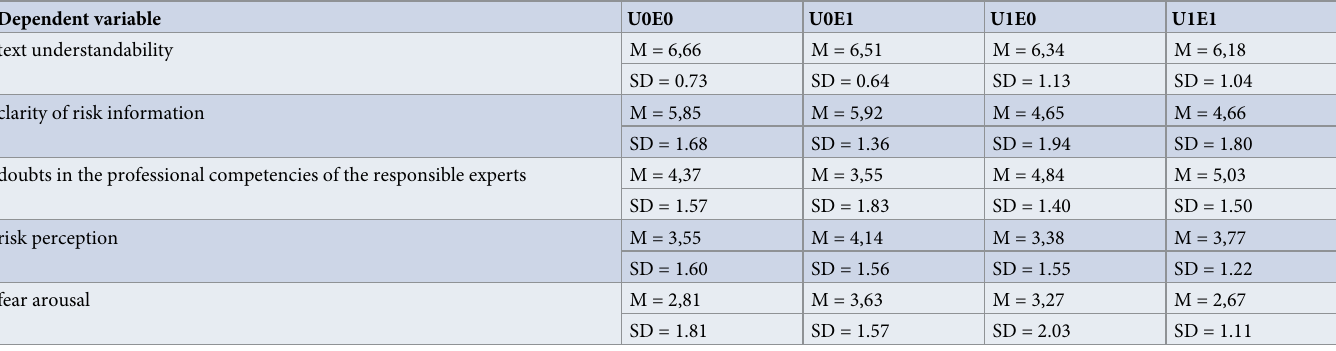
Means (M) of the dependent variables, measured on 7-points Likert scales (the higher the scores, the higher the value on the variables) and standard deviations (SD) across the four treatment levels in experiment R1(hazard identification).